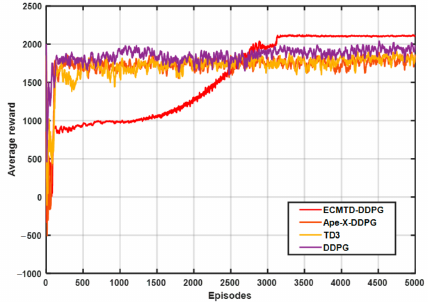
Figure 6. Training